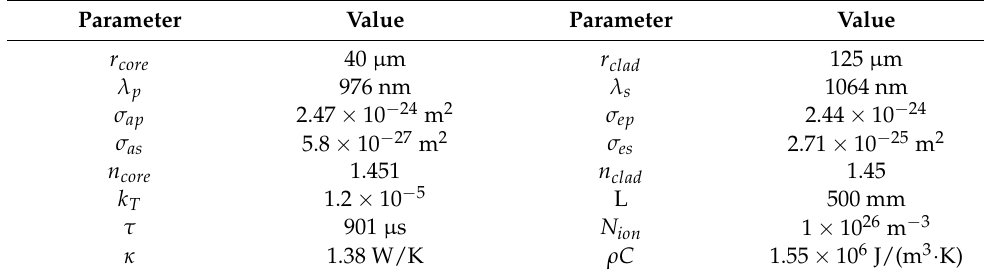
Table 1. The simulation parameters of fiber amplifiers.